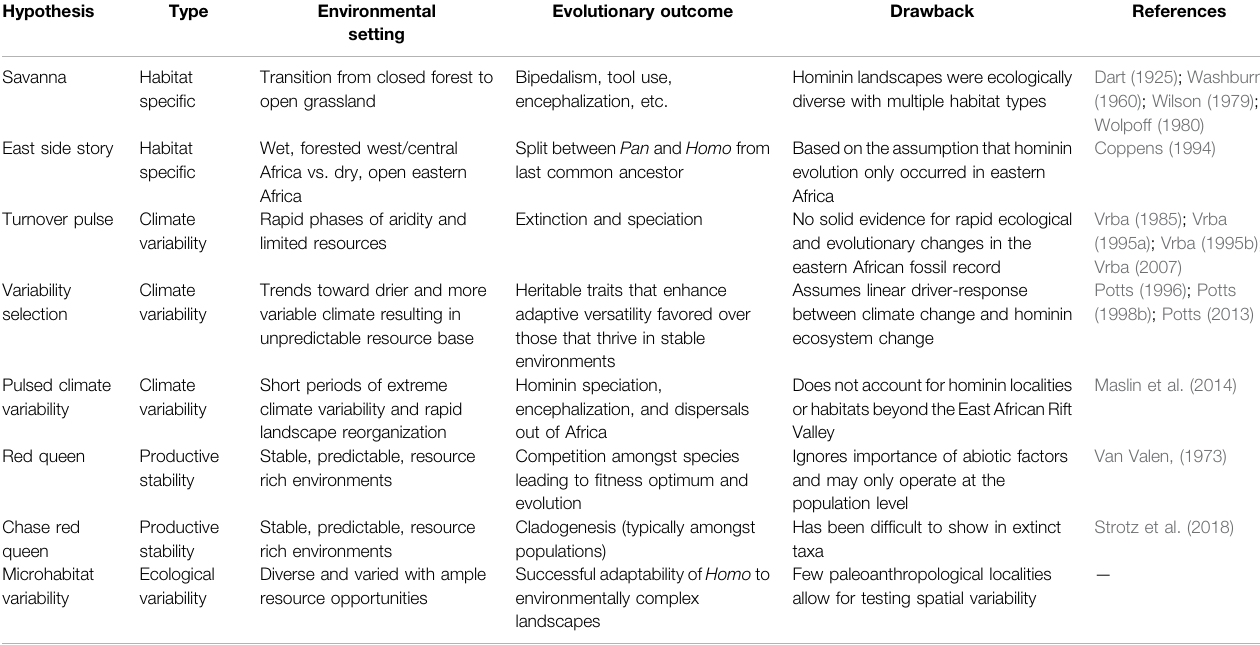
TABLE 3 | Synthesis of selected environmental hypotheses for human